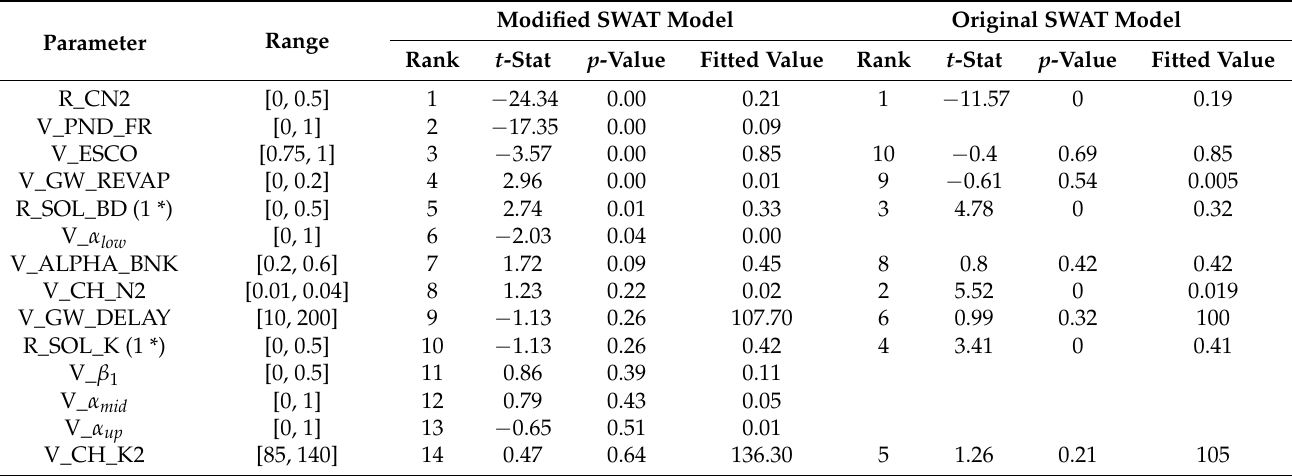
Table 4. Sensitivity ranking and values of the parameters for calibration of the modified and the original SWAT model for the Daotian River catchment.